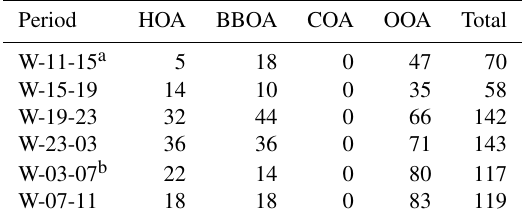
Table 2. Average seasonal concentrations of time-of-day PMF fac- tors for the 2017 monsoon season (in µgm − 3